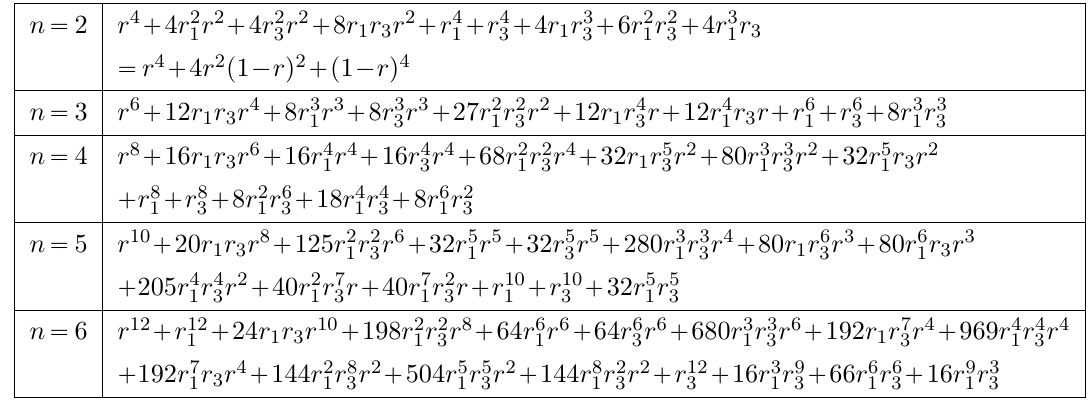
Table 1 . The replica negativities exp p E 2